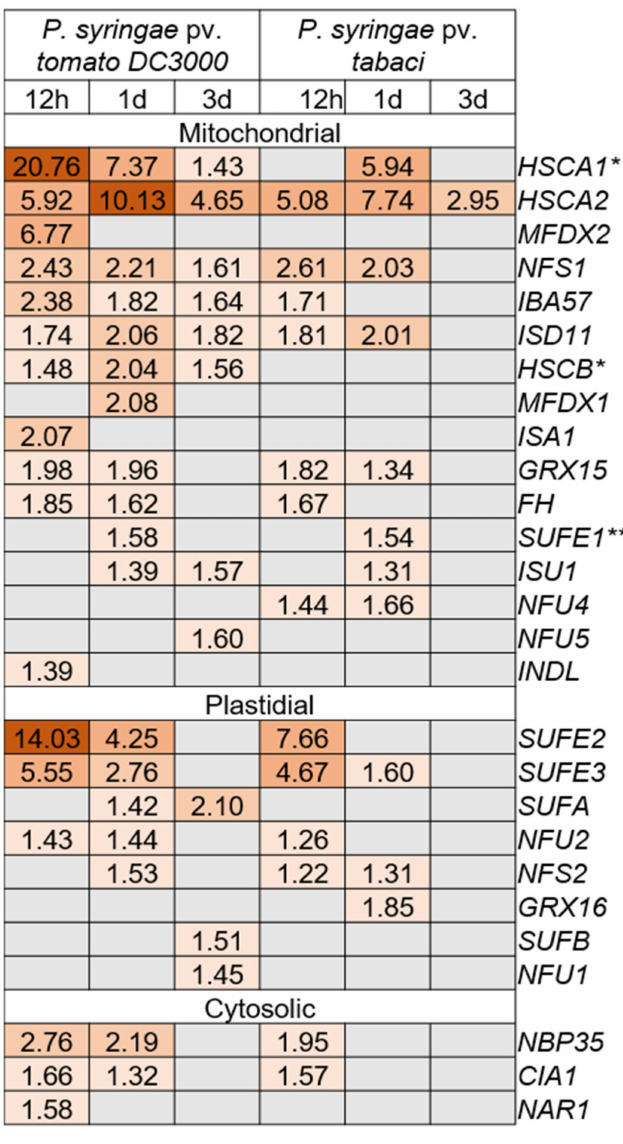
Figure 1. RNA-seq analysis showing upregulation of 27 Fe-S cluster pathway genes in WT plants upon host and nonhost pathogen infection: Heatmap showing differentially expressed genes with their respective fold-change from 27 upregulated Fe-S cluster genes upon host ( P. syringae pv. tomato DC3000) and nonhost ( P. syringae pv. tabaci ) pathogen infection in the WT. Differentially expressed genes at 12 h, 1 day, and 3 days were required to have a False-Discovery Rate (FDR) <0.05 compared to the 0 h time point control. The predicted localization of proteins encoded by these genes are shown as plastids or mitochondria or cytosol. Upregulated genes are color coded from light to dark red according to increasing fold-change values. * Gene that encodes a protein that also localizes in the cytosol. ** Gene that encodes a protein that also localizes in the